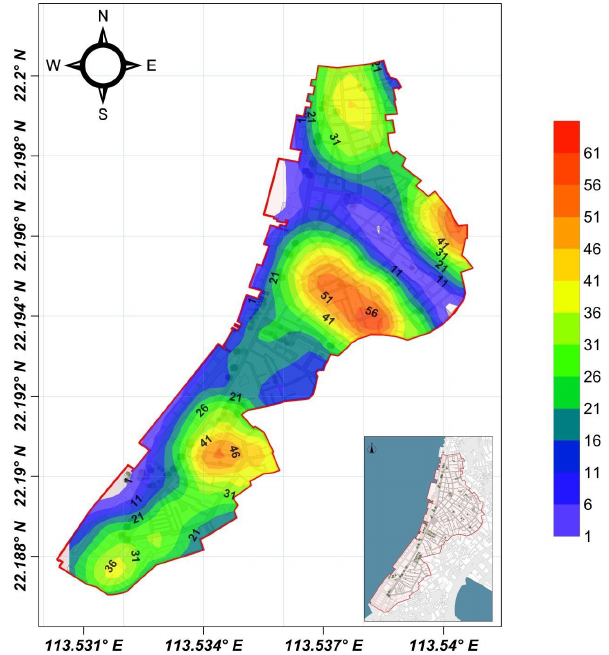
Fig. 2 Core density analysis of spatial distribution of catering at the Inner Harbour of Macao. Photo source : The map was drawn based on the POI data of Gaode map. POI, points of